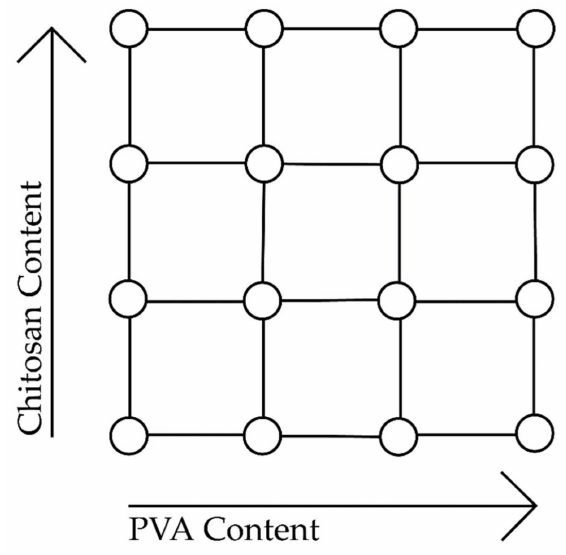
Figure 3. Model of a 4 2 factorial design scheme.